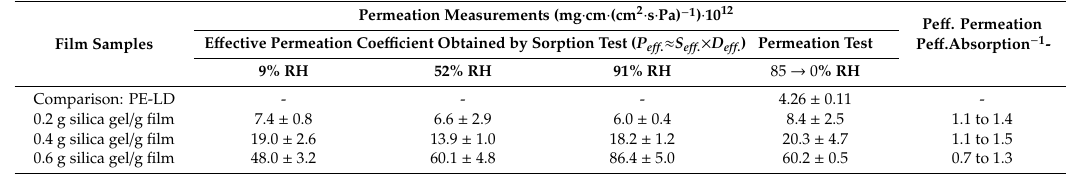
Table5. E ff ectivepermeationcoe ffi cientscalculatedfromresultsofsorptionexperimentsandpermeation coe ffi cients measured with steady-state permeation experiments (steady state); 23 ◦ C.